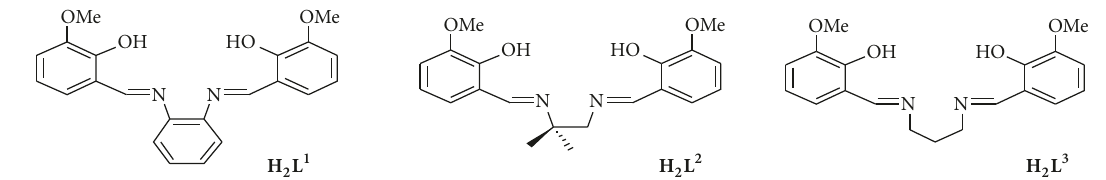
Figure 1: Structures of the Schiff base ligands H 2 L 1 –H 2 L 3